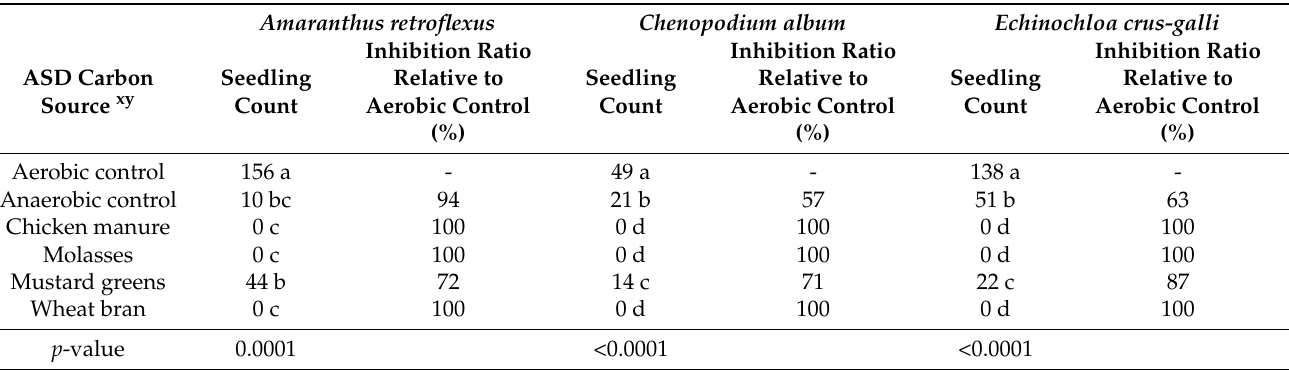
Values in a column followed by different letters are significantly different at the indicated p -value according to Fisher’s LSD test after square root transformation. Values are means of two experiments, each with three replications. Relative to the aerobic